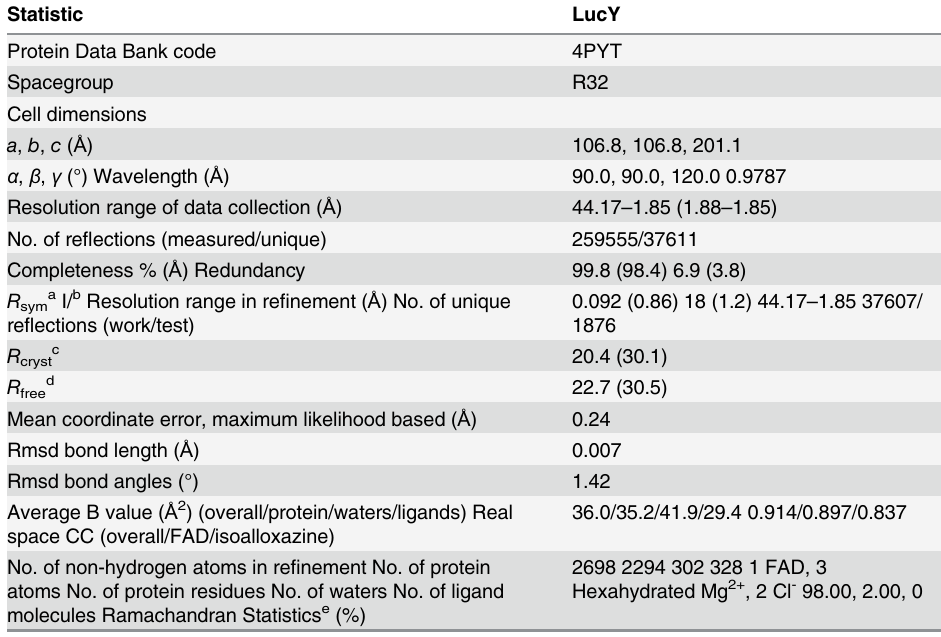
Table 2. Statistics for data collection and